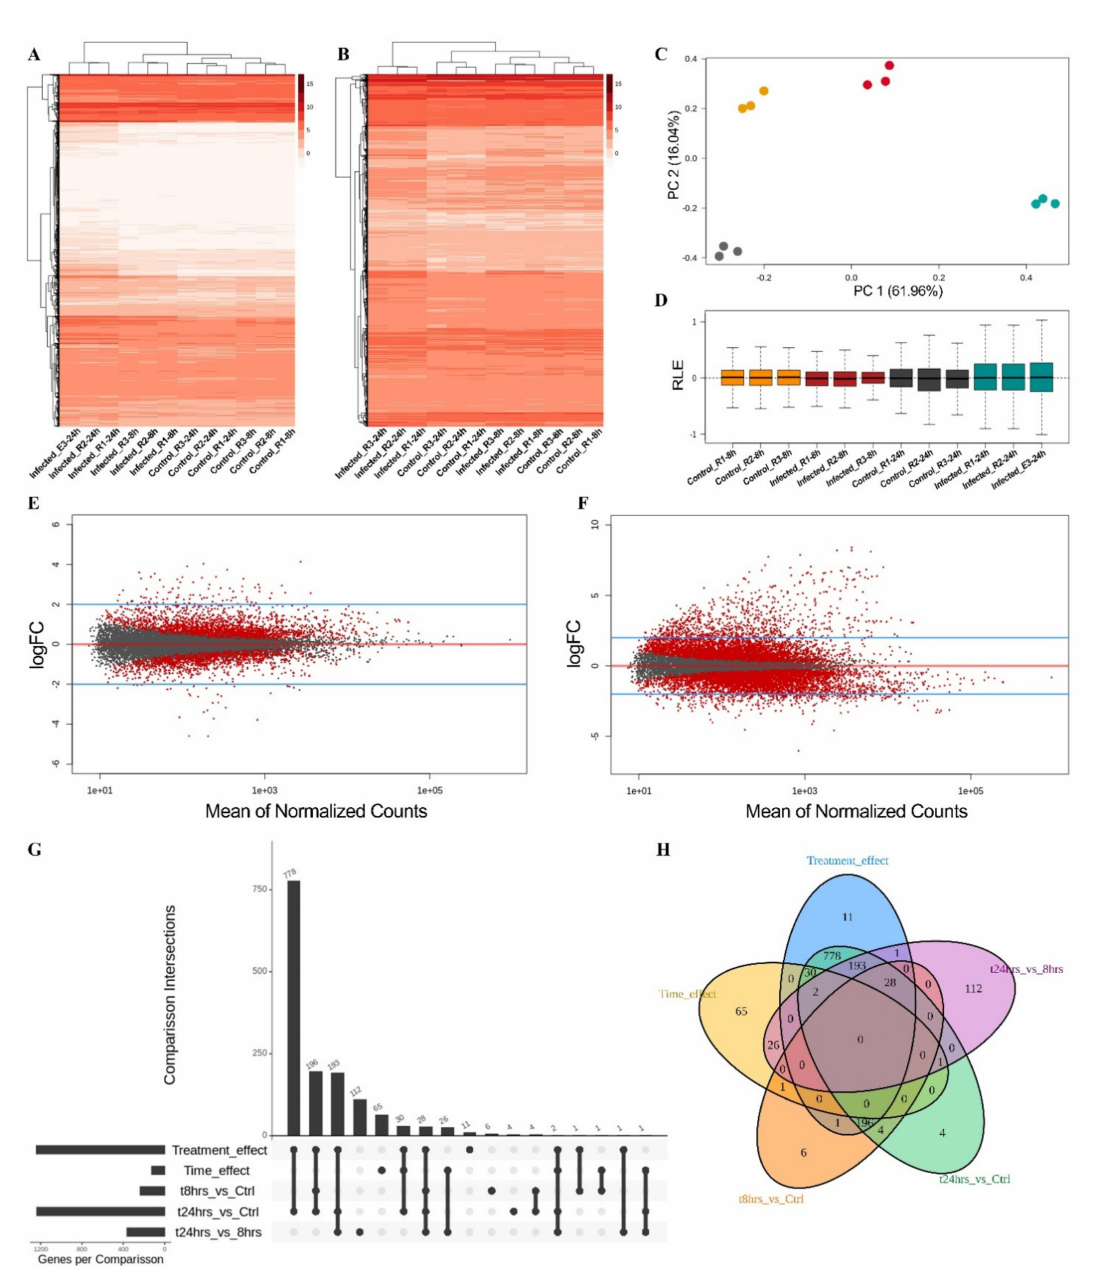
Figure 3. Differential gene expression analysis of P. patens under infection with C. gloeosporioides . ( A , B ) Effect of filtering out the genes with low read counts on the gene expression profile and discrimination between experimental groups by unsupervised clustering. ( C ) Principal component analysis (PCA) after upper-quartile normalization, showing the clustering of the treatment groups. ( D ) Relative log expression (RLE) plot after upper-quartile normalization, showing the read distribution across samples. ( E , F ) Mean difference plots of differentially expressed genes under a time effect and treatment effect, respectively. ( G ) Upset plot showing the sets of differentially expressed genes from the different comparisons between samples, including the quantitative analysis of the aggregate intersections between comparisons. The vertical bars show the number of intersecting genes between comparisons, denoted by the connected black circles below the histogram. The horizontal bars show the gene set size. ( H ) Venn diagram, showing the overlap among the differentially expressed genes of different